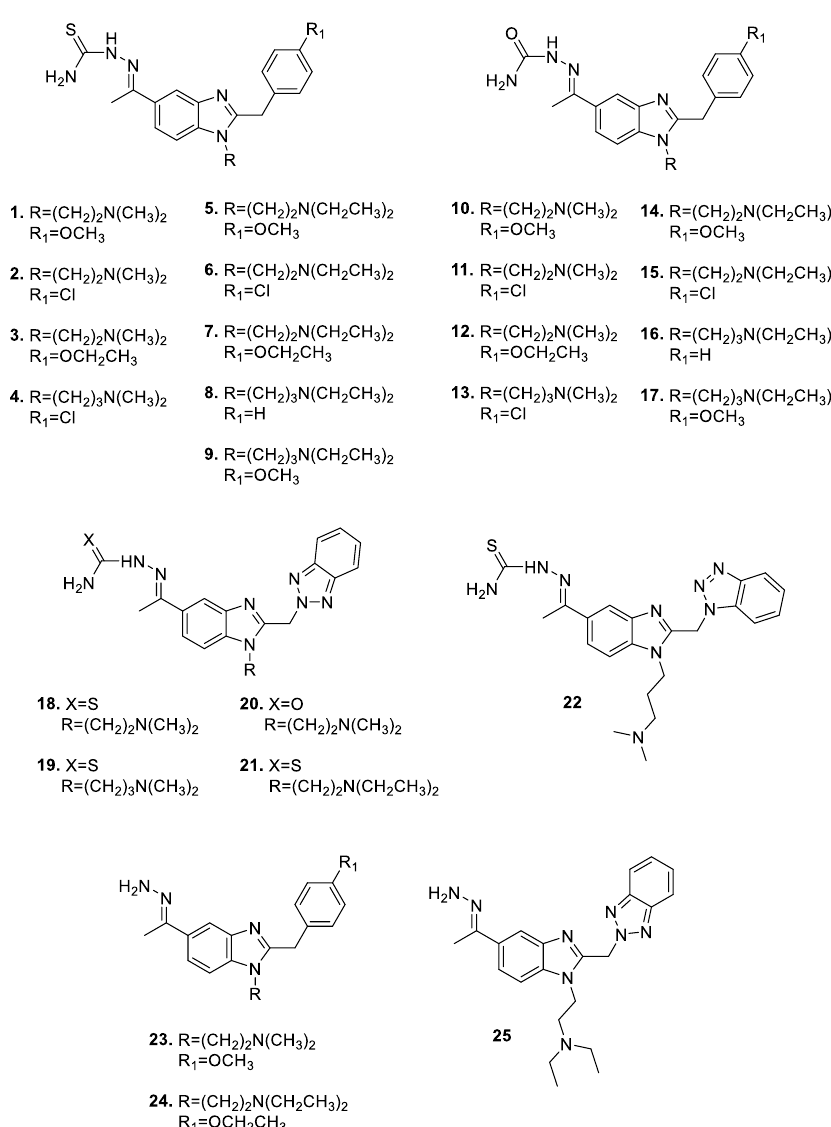
Figure 3. Chemical structures of the novel (thio)semicarbazone- and hydrazone-incorporating benzimidazoles ( 1–25 ).